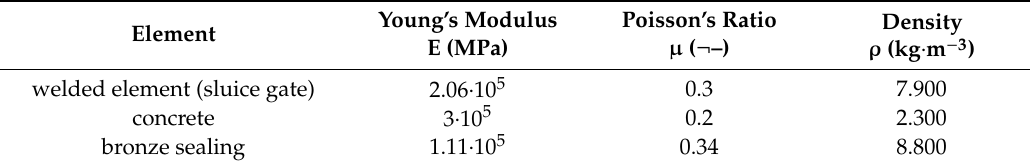
Table 7. Material properties of used materials.